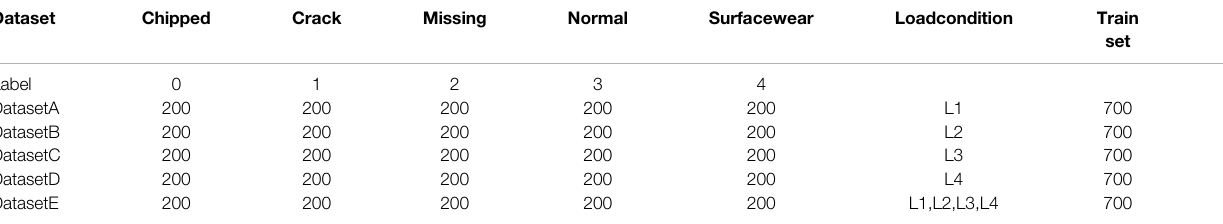
TABLE 4 | time-frequency images datasets of Chongqing University gearboxes. Dataset